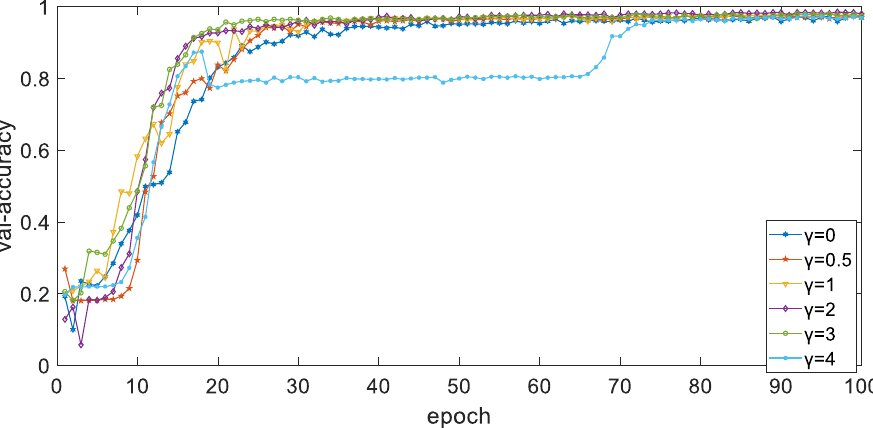
Figure 10. The curve of accuracy of validation set with different epoch when parameter γ is differ- ent.